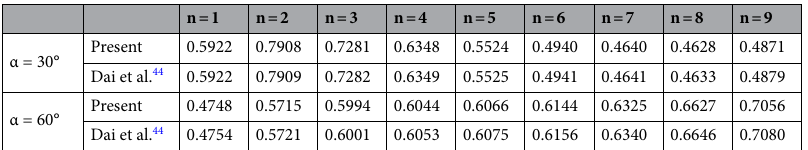
Table 3. First dimensionless natural frequency (Ω n1 = ω n1 b [ ρ (1 − ν 2 )/ E ] 0.5 ) of an SS isotropic homogenous truncated conical shell with various values of the semi-vertex angle ( ν = 0.3, L sin α / b = 0.25, h / b = 0.01).